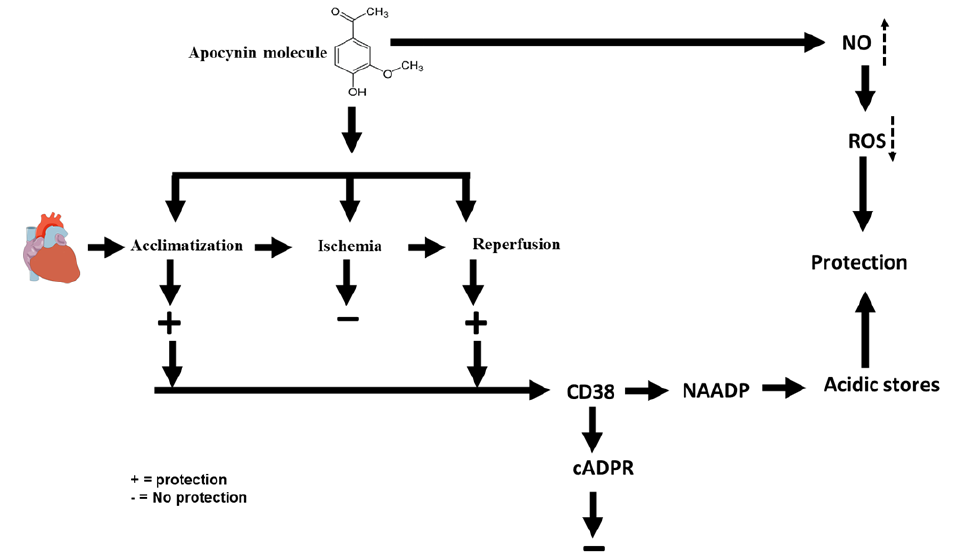
Figure 8. Schematic representation showing the protective treatments of apocynin and the potential pathways for this protection. NO, nitric oxide, ROS, reactive oxygen species; NAADP, nicotinic acid adenine dinucleotide phosphate; cADPR, cyclic adenine diphosphoribose: CD38, cluster of differentiation 38. (Upward pointing dotted arrow indicate increase in NO and downward pointing dotted arrow indicates decrease in ROS).